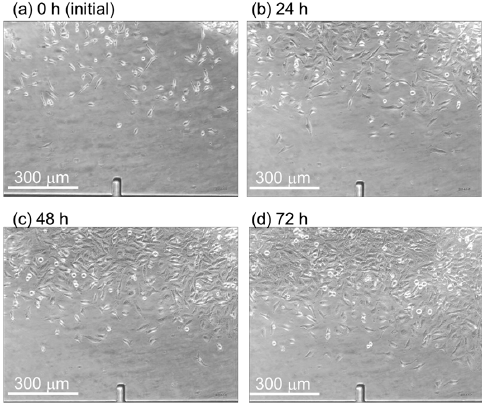
Figure 14. Cell proliferation in the cell culture chamber. The HeLa cells grew from ( a ) the initial state to ( b ) 24 h; ( c ) 48 h; and ( d ) 72 h.